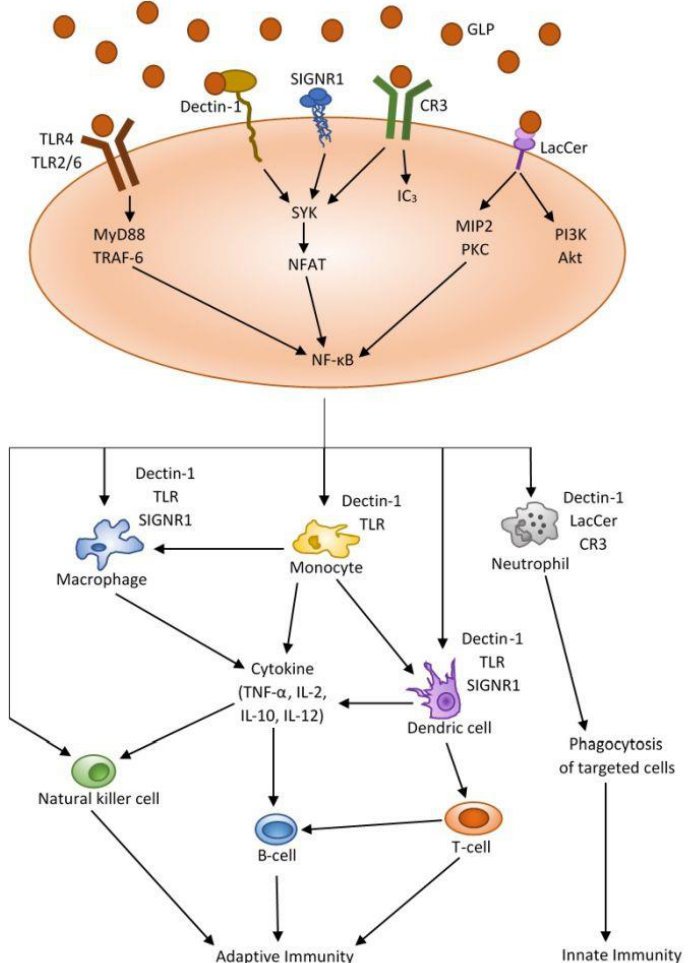
Figure 3. Mechanisms of immune activation by polysaccharides from Ganoderma lu-cidum . (Akt— protein kinase B; CD25— α -chain of interleukin-2 receptor; CD71—trans-ferrin receptor-1; CR3— complement receptor-3; DAG—diacylglycerol; IP3—inositol triphosphate; LacCer—lactosylceramide receptor; MIP2—macrophage inflammatory protein-2; MyD88—myeloid differentiation primary response 88; NFAT—nuclear factor of activated T-cells; NO—nitric oxide; PKA—protein kinase A; PKC—protein kinase C; SIGNR1—C-type lectin receptor; SYK—tyrosine protein kinase; TRAF-6—TNF-receptor associated factor 6).